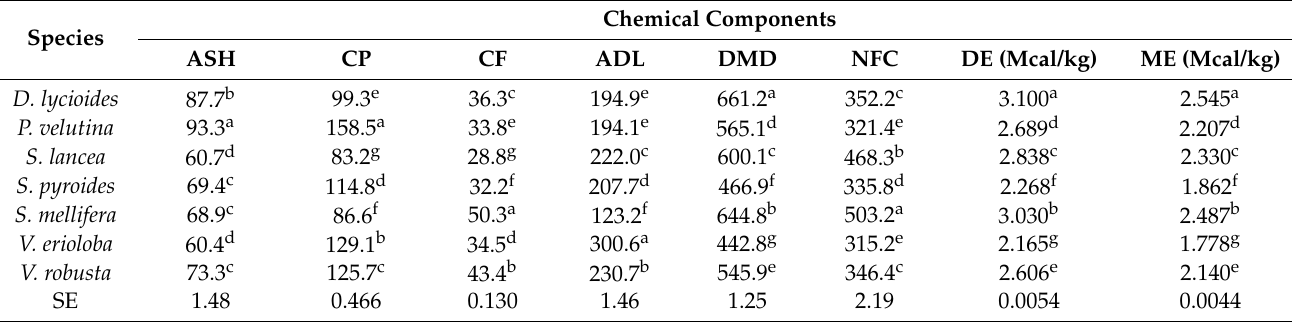
Table 2. Chemical composition (g/kg DM, unless otherwise stated) of browse species found in AKS-CH soil types. Species